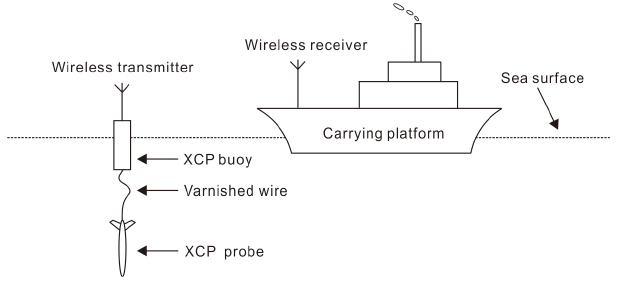
Figure 1. Schematic diagram of expendable current profiler.